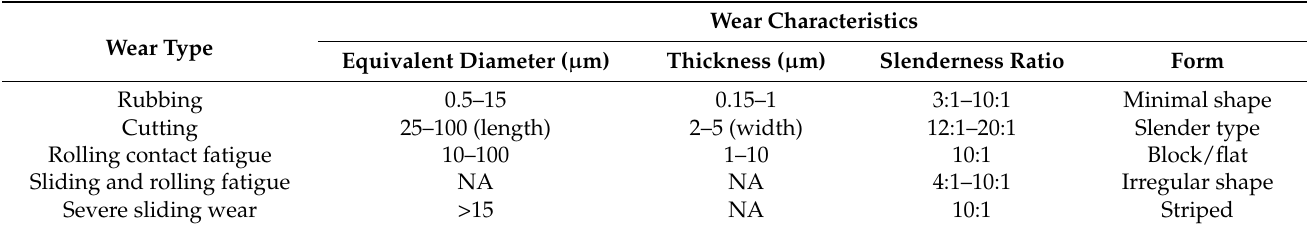
Table 1. Characteristics of wear particles produced by five types of